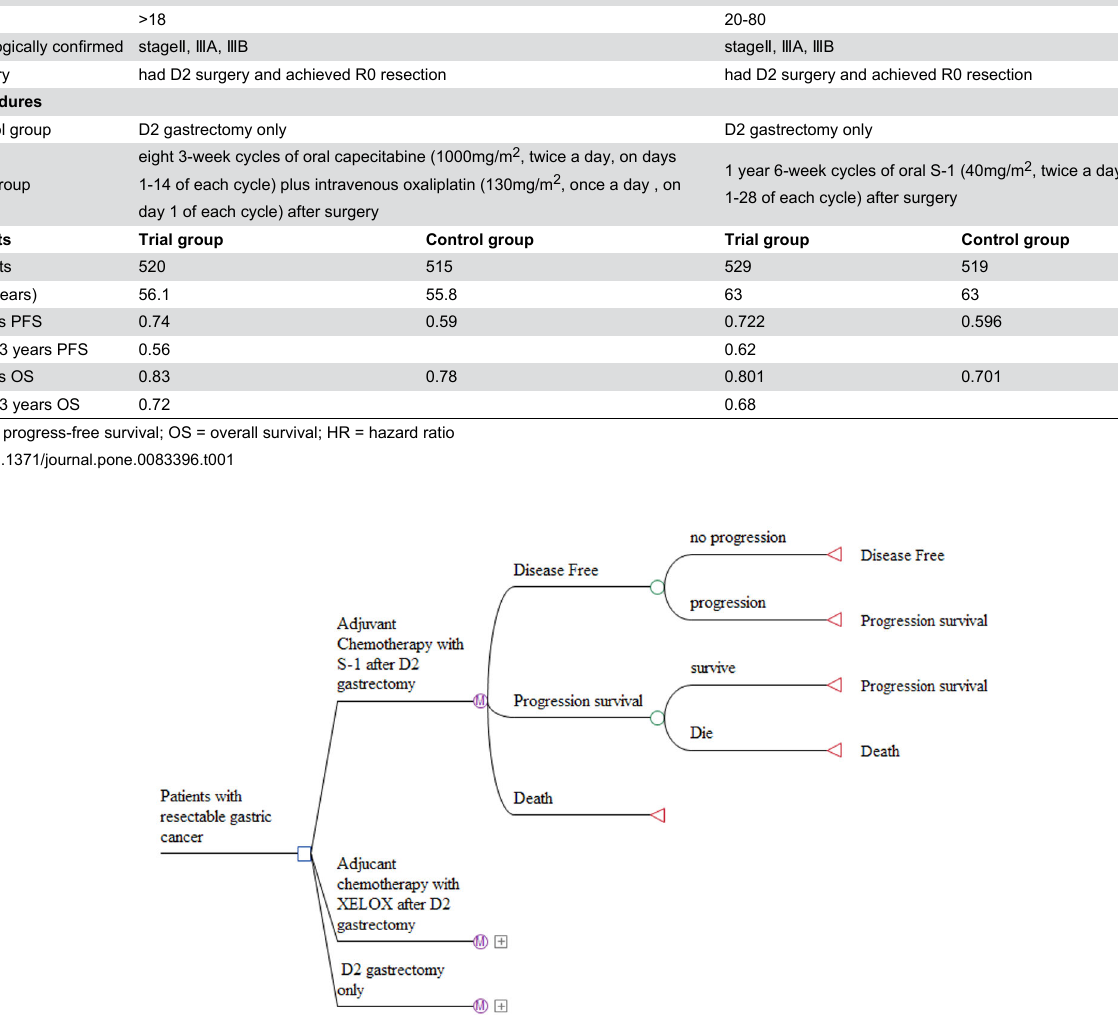
Figure 1. Markov model used to evaluate three treatment strategies for resectable gastric cancer. doi: 10.1371/journal.pone.0083396.g001 Table 2. Goodness of fit by the possible distributions of survival curves for surgery-only